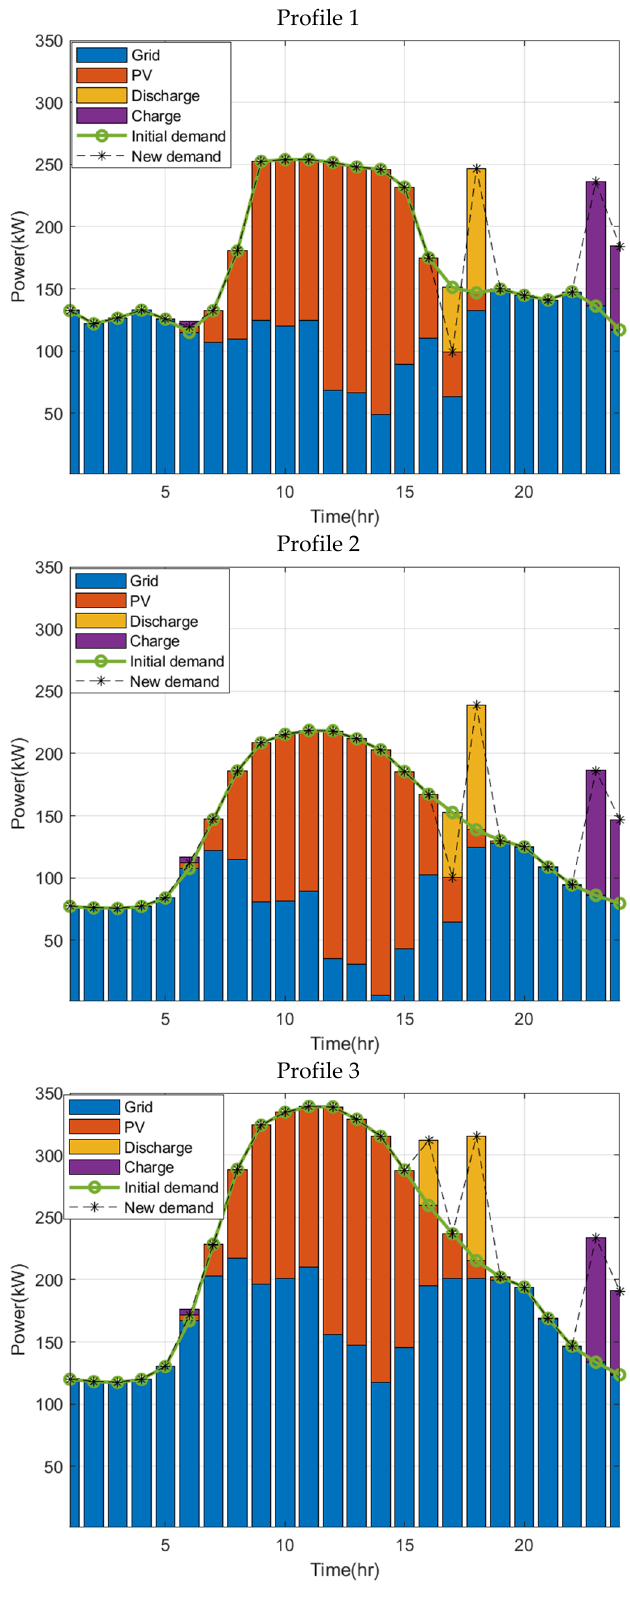
Figure 11. Operation of ESS in April. Profile 1—Using real smart meter data (Section 4.1.1); Profile 2—Using energy bills, standard profiles, and measurement for validation (Section 4.1.2); Profile 3—Using short-term measurement, standard profile. and contracted power (Section 4.1.3).